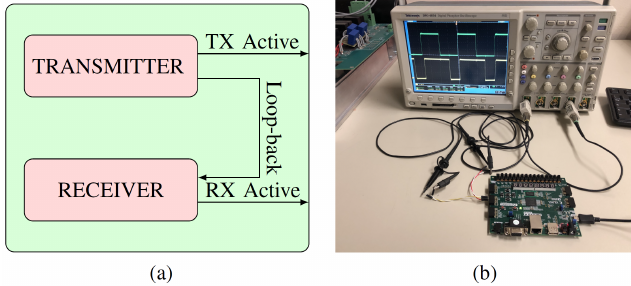
Figure 10. Experimental setup: Diagram of hardware implemented in FPGA ( a ) and picture of the experimental setup ( b